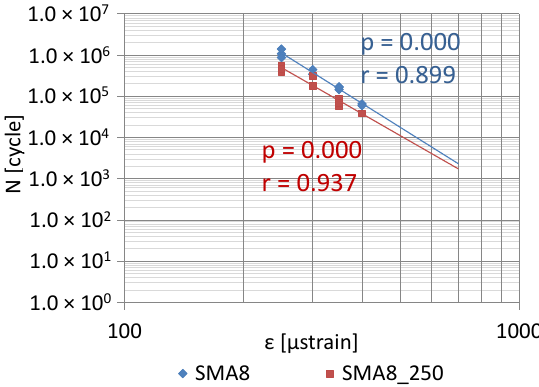
Figure 15. Fatigue life of SMA8 mixture with PMB45/80-55, before and after heating at a temperature of 250 °C (1 h).